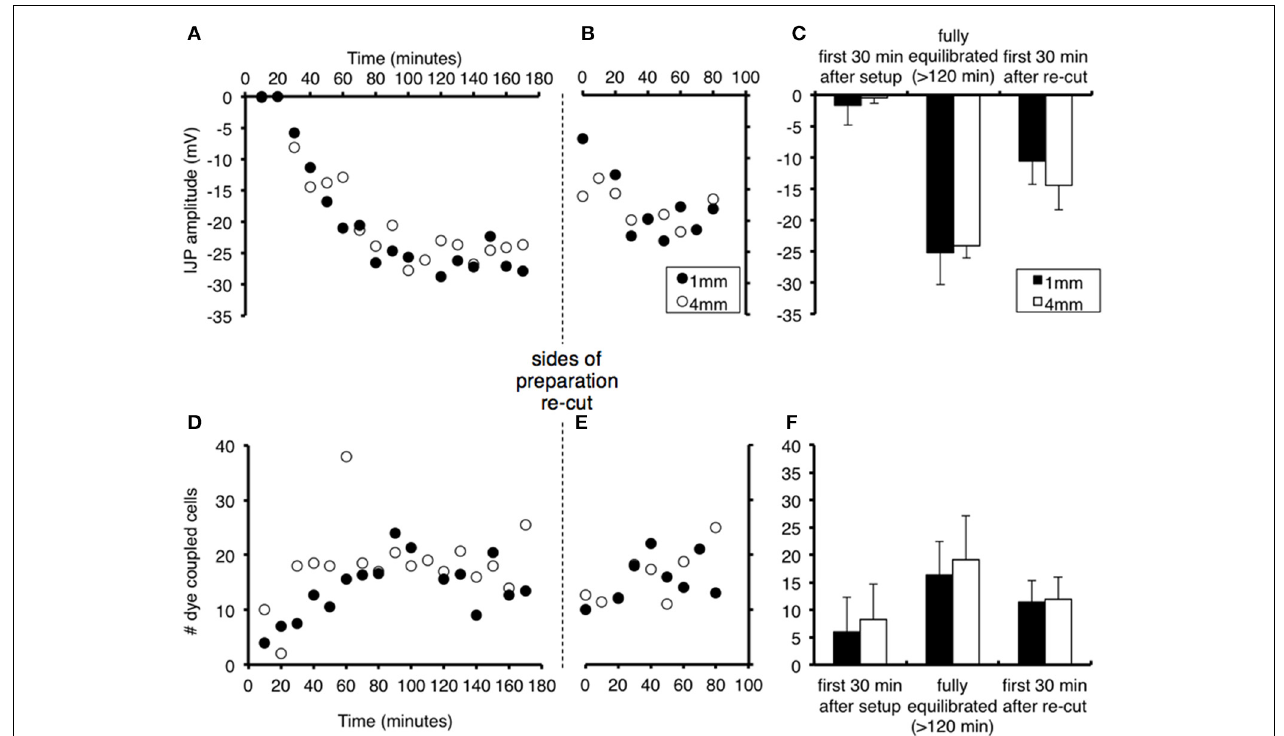
FIGURE 2 | Effects of proximity to the edge of the preparation on recovery of responses and effects of re-cutting the edges of the preparation. Recordings were made alternately from smooth muscle cells 1mm (filled circles) or 4mm from the edge of the tissue (open circles) after initial set up and after re-cutting both sides of the preparation. Symbols represent averaged responses in 10min bins, in order to display clearly the similar time courses for cells at 1 and 4mm. (A) The IJP increased in amplitude from t = 0, with similar time course for cells 1mm (black dots) or 4mm (gray squares) from the edge of the preparation ( n = 4). Edges were re-cut at the vertical dashed line. (B) IJPs were significantly reduced immediately after the cut, but not to the